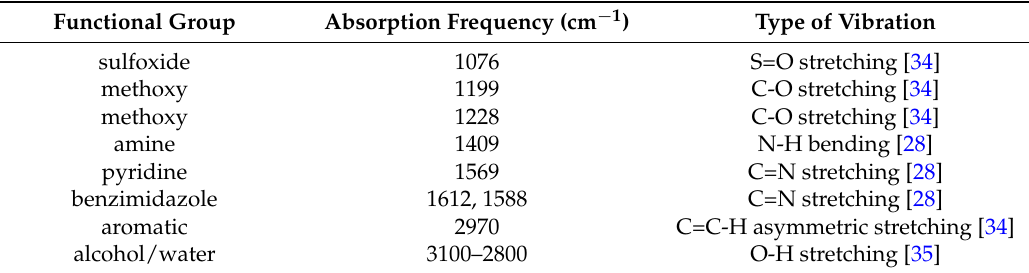
Table 2. IR spectroscopy absorption frequencies and corresponding functional